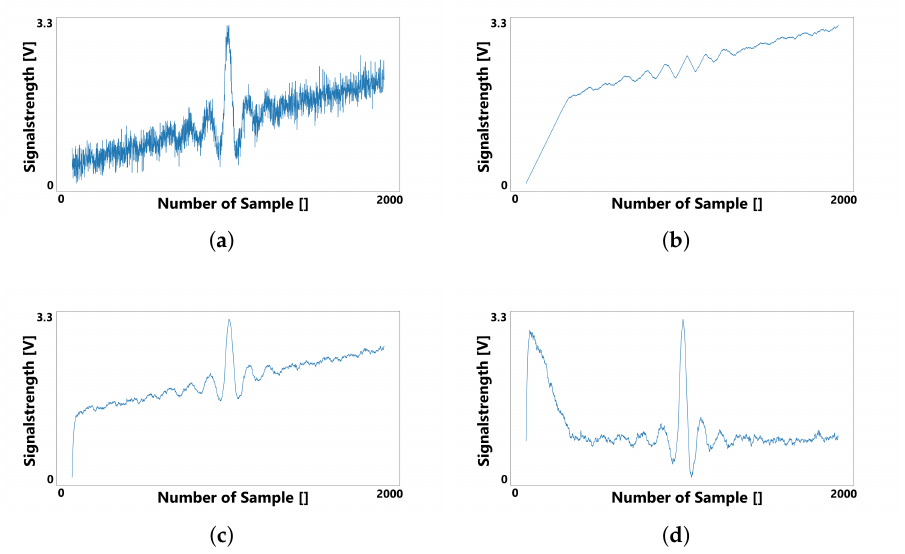
Figure 6. The noisy signal ( a ) smoothed using an exponential moving average ( c ) (with s = 0.9) and a linear baseline ( b ), resulting in the signal depicted in ( d